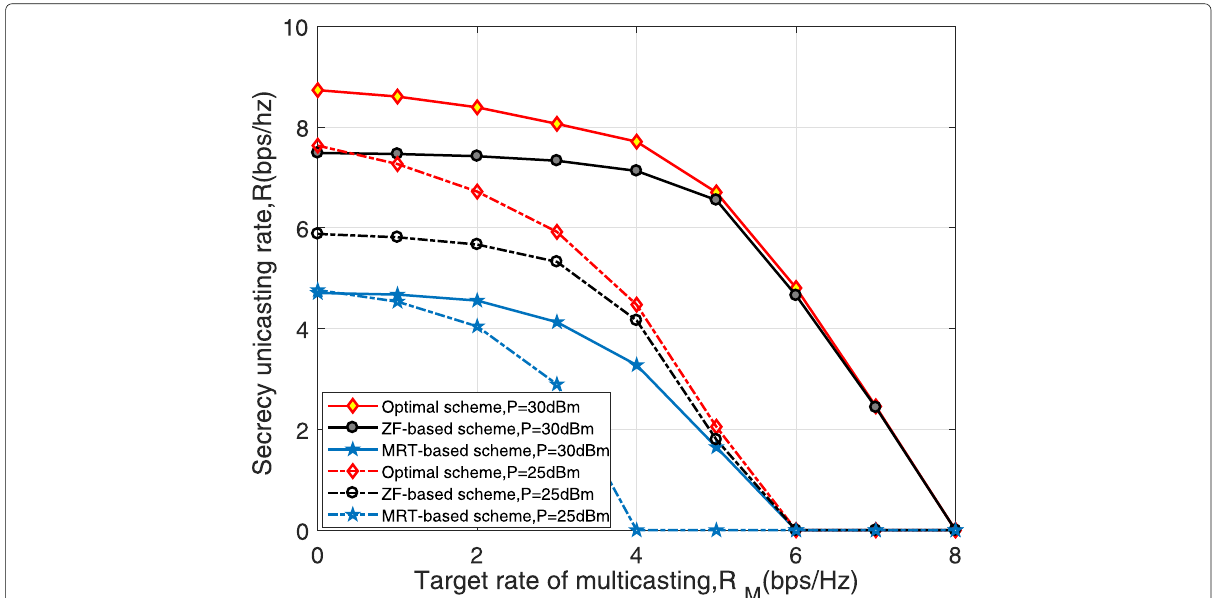
Fig. 5 Secrecy unicasting rate versus the target rate of multicasting with K = 5